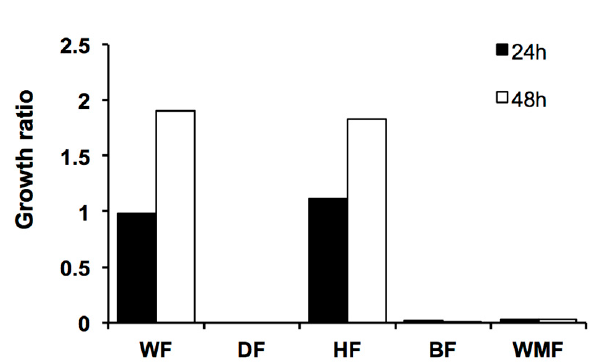
Figure 5. Susceptibility of C. albicans to M. arbuscula fractions. Growth was monitored after 48 h of incubation at 30 °C. Growth ratios were determined in comparison to control (untreated) cells. Growth ratios below 0.5 indicate active fractions. Table 4. Sub-fractions obtained from the fraction E35-DF. Sub-Fraction